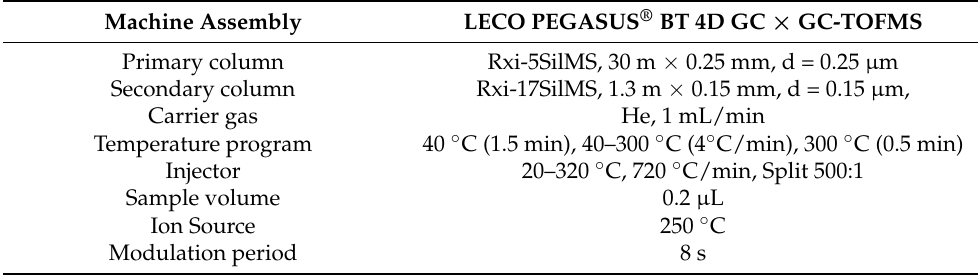
Table 3. Parameters of GC ×